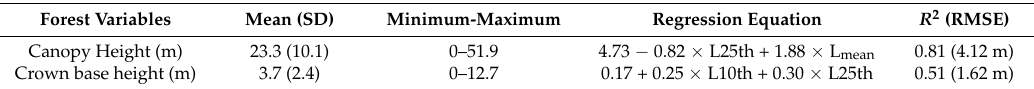
Table 4. Details of canopy height and crown base height field data, and details of resulting regression with Lidar